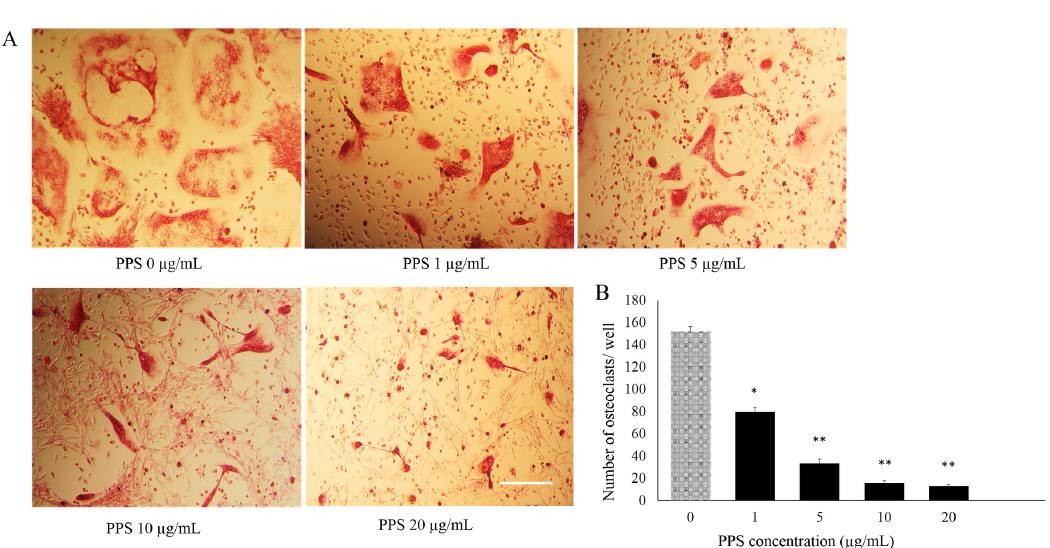
Fig 2. Shows inhibitory effect of PPS on canine OC differentiation. (A) The cells were treated with various concentrations of PPS followed by M-CSF (20 ng/mL) and RANKL (50 ng/mL) for 7 days. The cells were stained for TRAP stain and TRAP-positive cells ( � 3 nuclei) were counted. Scale bar- 100 μ m. (B) Bar graphs show the number of OC cells/well. Data are representative of three independent experiments and expressed as means ± SE. Means with � are significantly different from 0 μ g/mL of PPS ( � p < 0.05, �� p <